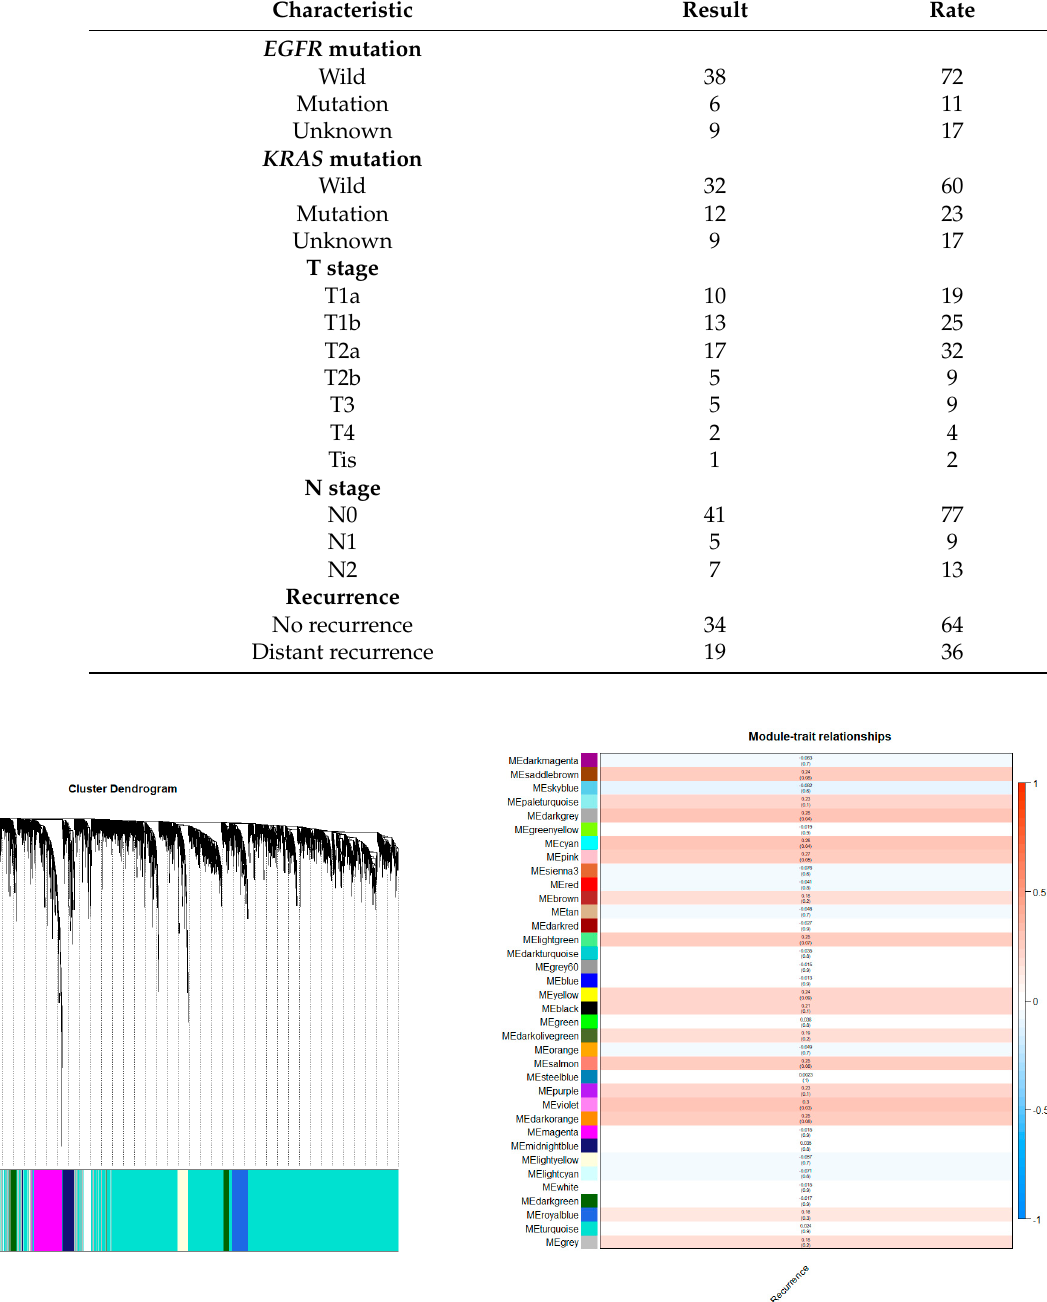
Figure 2. Gene regulation was performed through clustering. In total, 37 gene modules were generated, with each module comprising genes with similar expression patterns ( left ); the relationship between each module and distant recurrence is shown as a heatmap ( right ). The modules relevant to distant recurrence are the violet (module meaning = 0.3, p -value = 0.033), dark gray (module meaning = 0.28, p -value = 0.041), and cyan (module meaning = 0.28, p -value = 0.042)